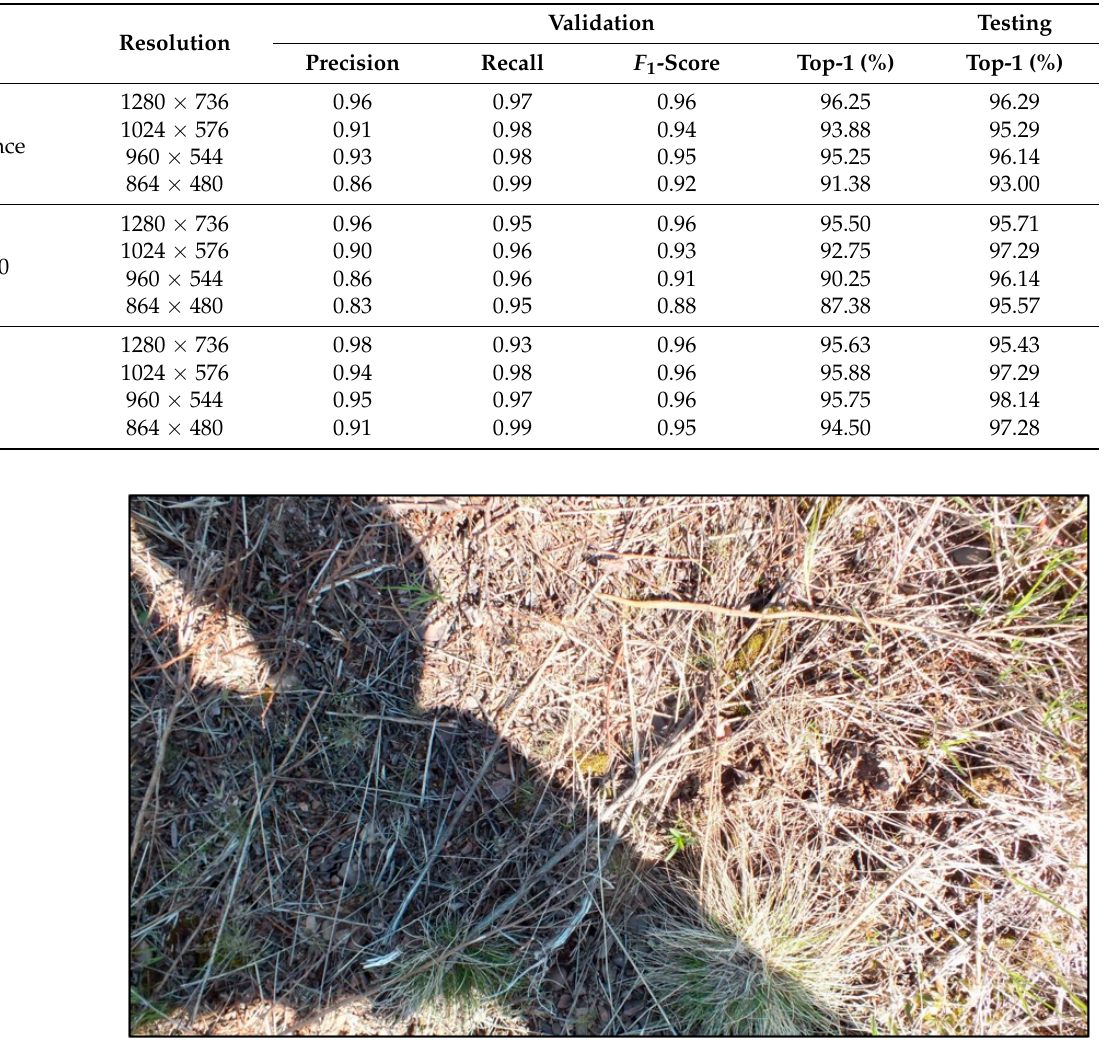
Figure 5. An image from spring 2019 with hair fescue that was misclassified as “not hair fescue” by Darknet Reference at 1280 × 736 resolution. The hair fescue tufts in this image are less prominent in this image than in Figures 3 and 4, which may have caused the classification error.